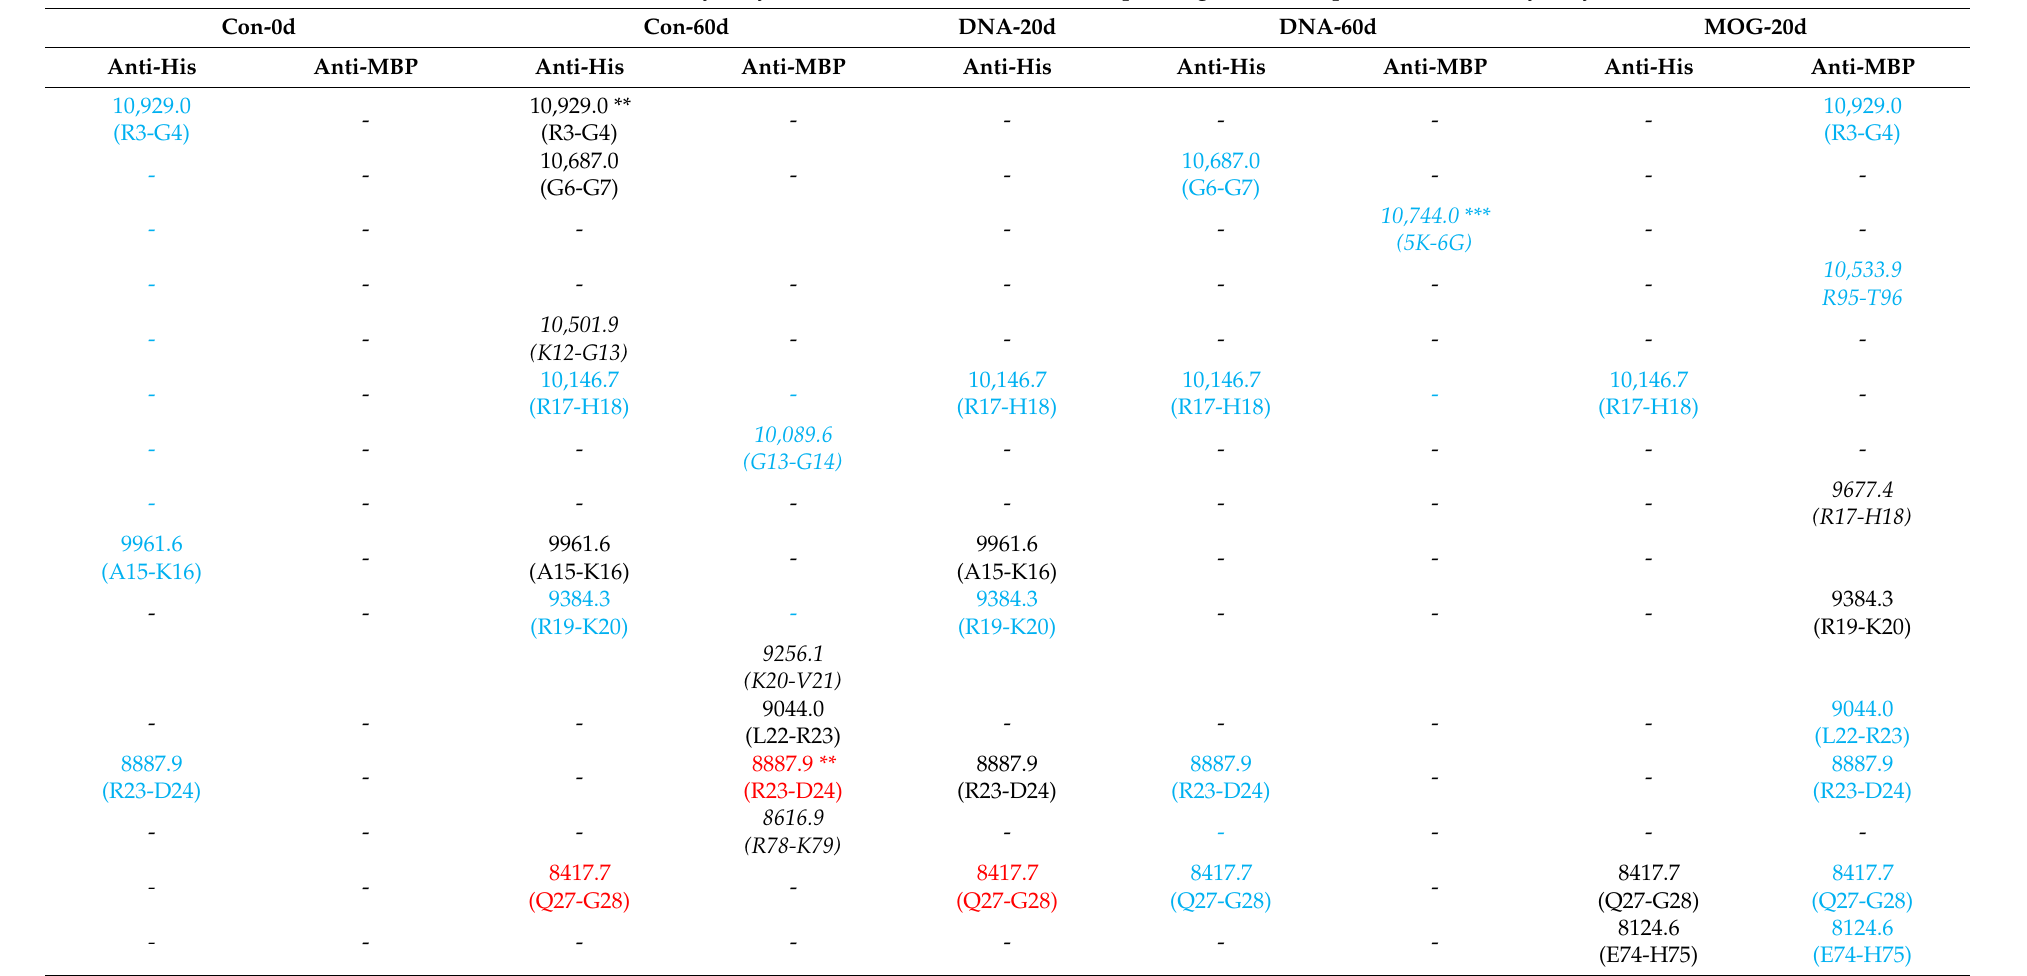
Table 1. Sites of H4 histone hydrolysis by IgGs against five histones and MBP *. Molecular Mass Products of Hydrolysis (Da) and in the Brackets Corresponding to These Peptide Sites of H4